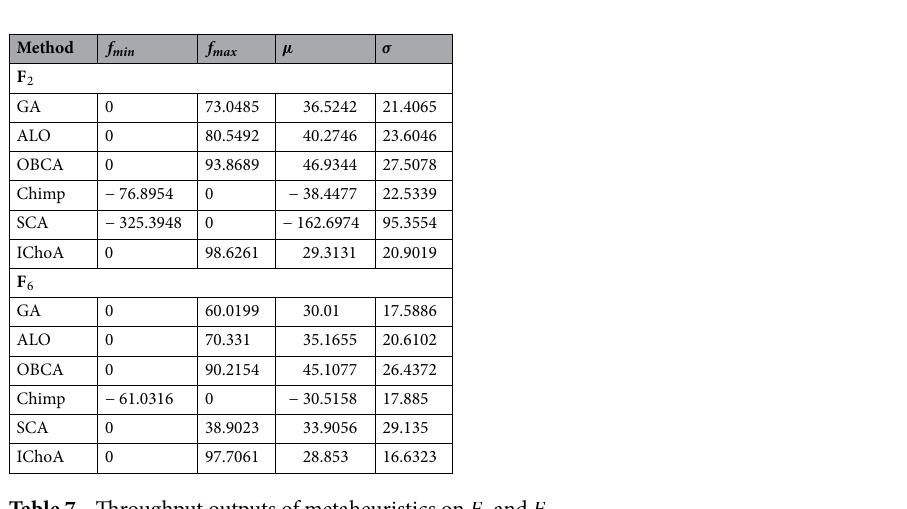
Table 7. Throughput outputs of metaheuristics on F 2 and F 6